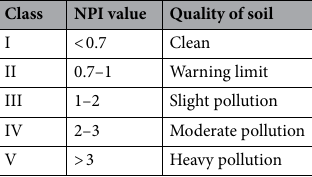
Table 5. Nemerow Pollution Index soil classes (adapted from Kowalska et al. 44 ).